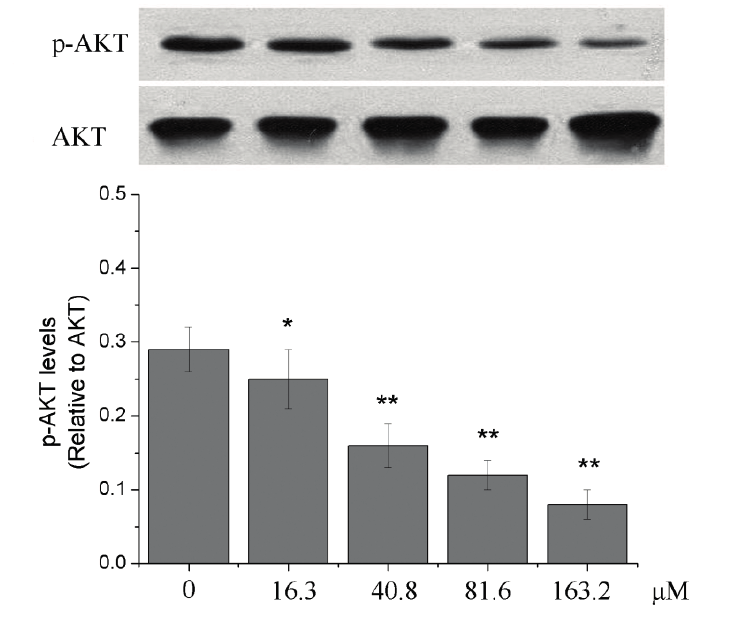
Figure 7. The effect of PD on the PI3K/Akt signaling pathway in U251 cells. U251 cells were treated with 0, 16.3, 40.8, 81.6 and 163.2 μ M of PD for 48 h. Then the expressions of p-AKT and AKT were evaluated by western blot assay. Each value is presented as mean ± SD ( n = 3). * p < 0.05 compared with 0 μ M PD; ** p < 0.01 compared with 0 μ M